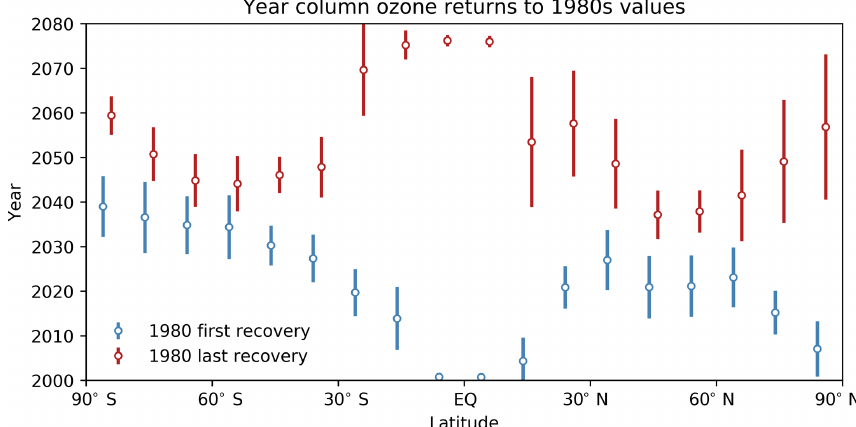
Figure 4. Year at which modelled total column ozone returns to 1980 annual mean values in each latitude band for the raw data from the seven UM-UKCA ensemble members. Blue points represent the first time annual mean values exceed the 1980 mean, while red points represent the final time annual mean values are lower than the 1980 mean. Error bars represent the 95% confidence intervals, calculated as twice the standard deviation of the return dates calculated for each ensemble